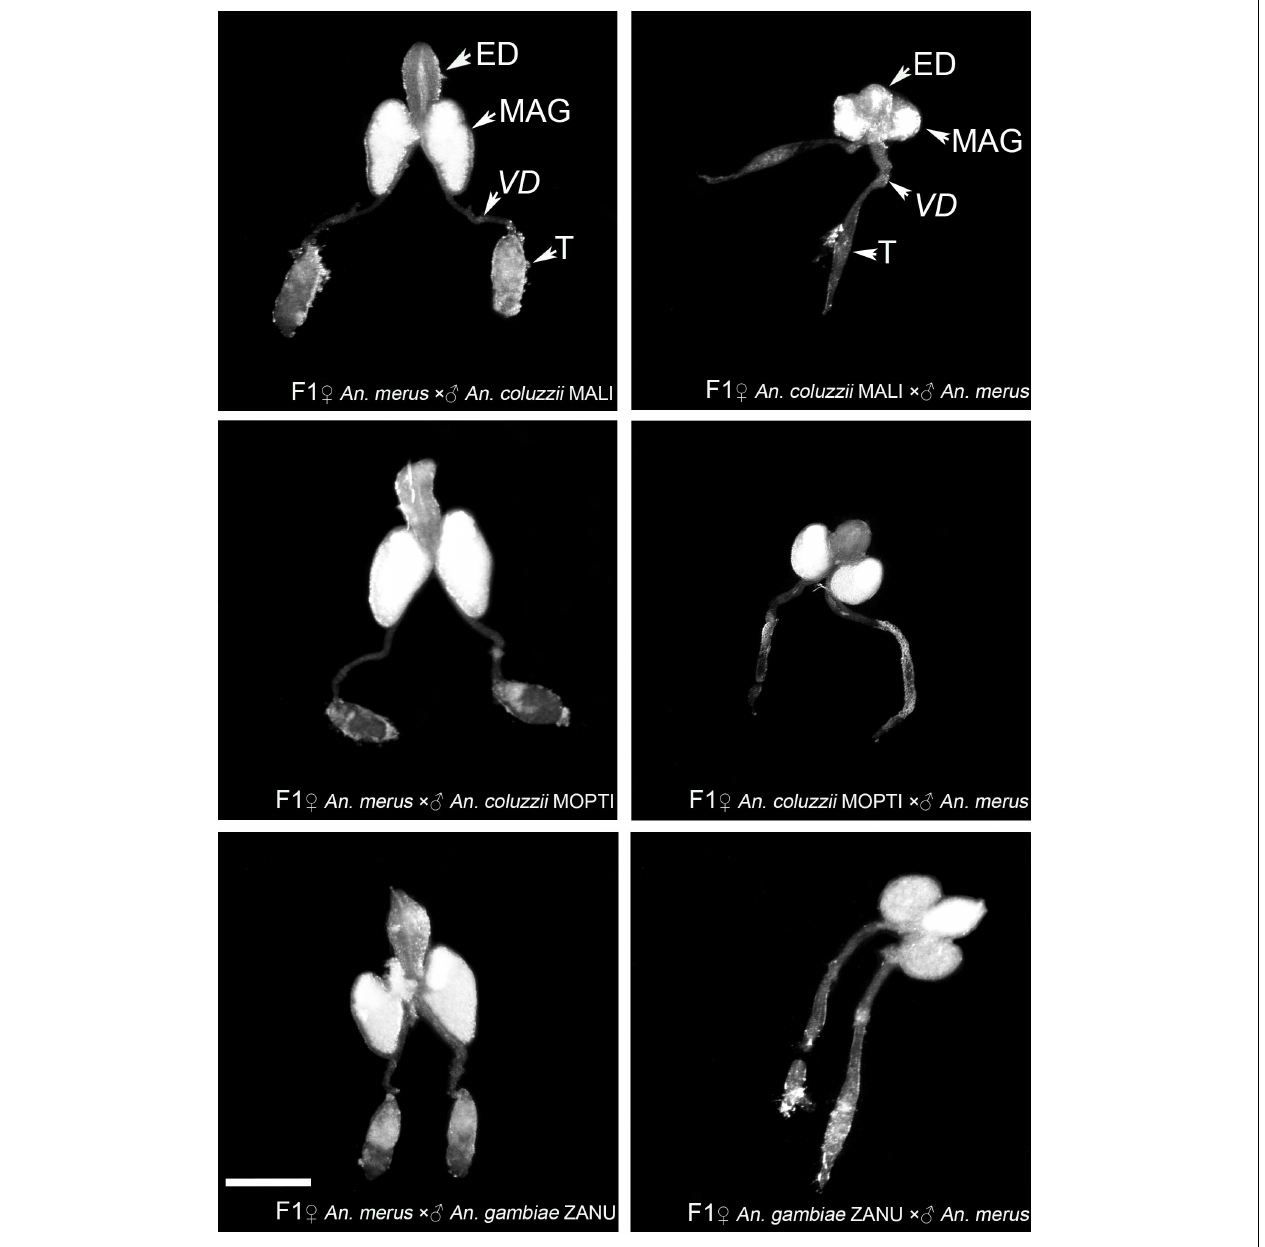
FIGURE 2 | Morphology of the male reproductive tracts in inter-species hybrids. MAG, male accessary gland; ED, ejaculatory duct; T, testis; VD , vas deferens . Scale bar = 0.5 mm.